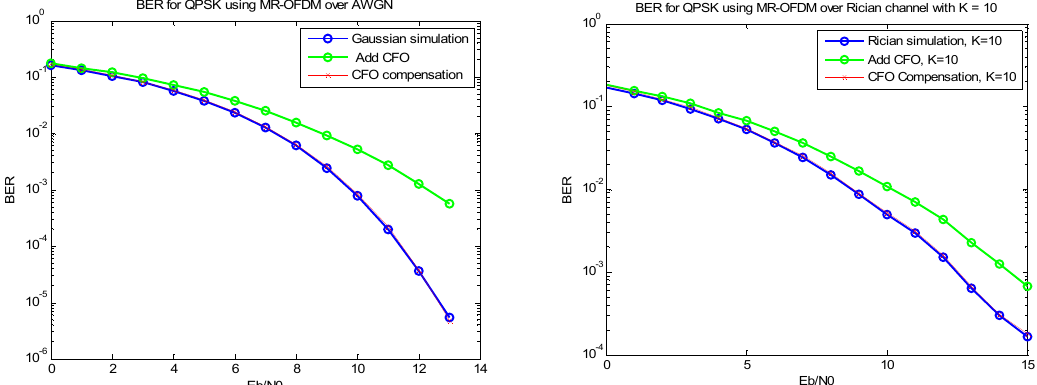
Figure 11. Simulation BER per Eb / N0 of MR-OFDM over the Gaussian and Rician channels with the acceleration of a = 0.5 m / s 2 .